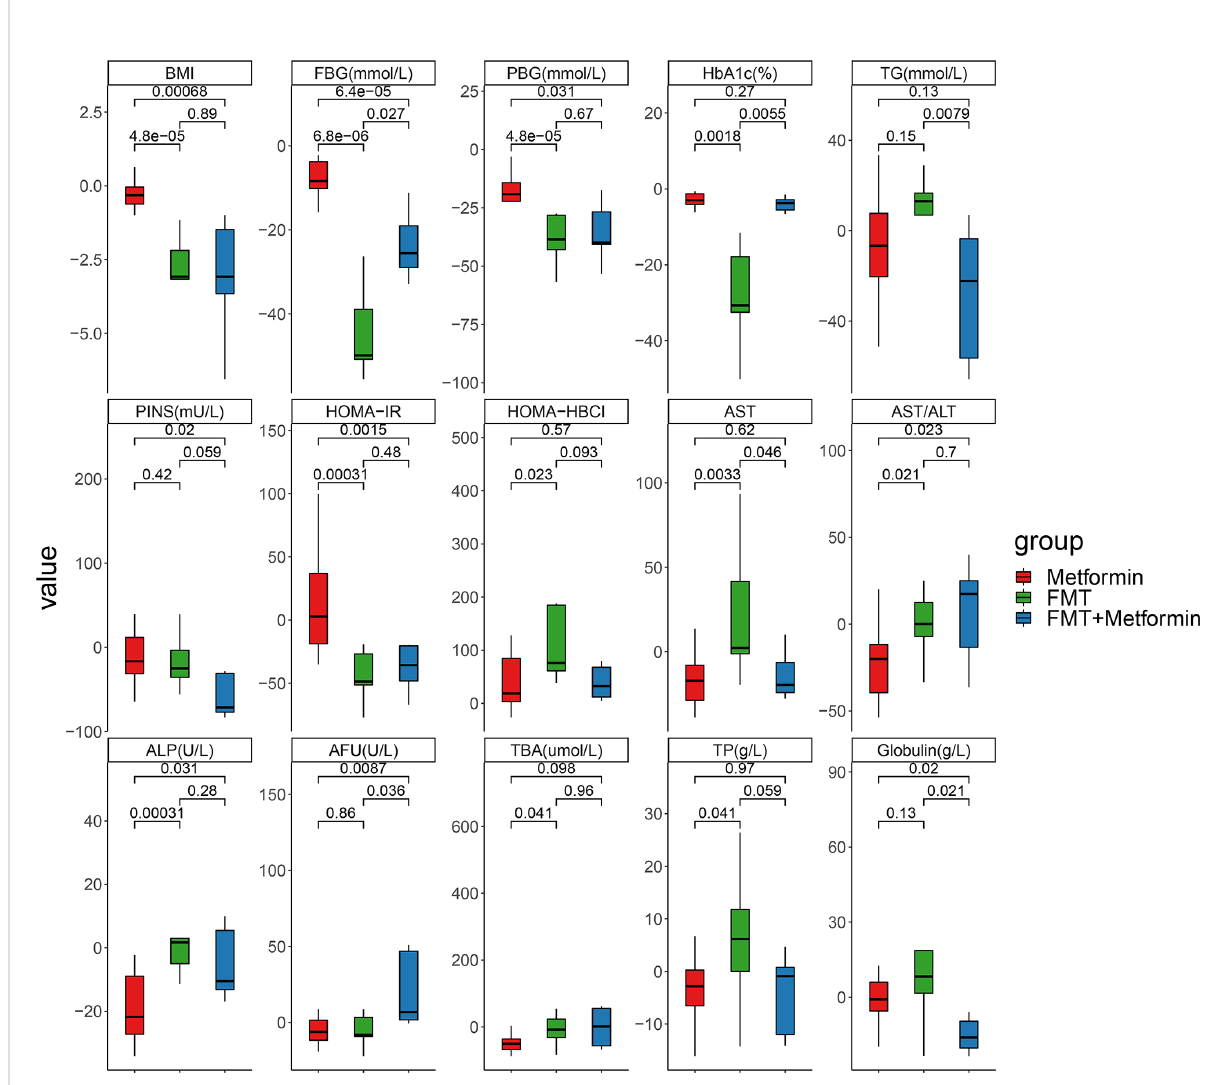
FIGURE 3 Fold changes of clinical indexes based on week 4 divided by week 0 in T2DM patients with different interventions. Pairwise comparisons between groups were conducted using the Wilcox test. Metformin, n=12 patients; FMT, n=9 patients; FMT plus metformin, n=8 patients. p <0.05 is de fi ned as statistically signi fi